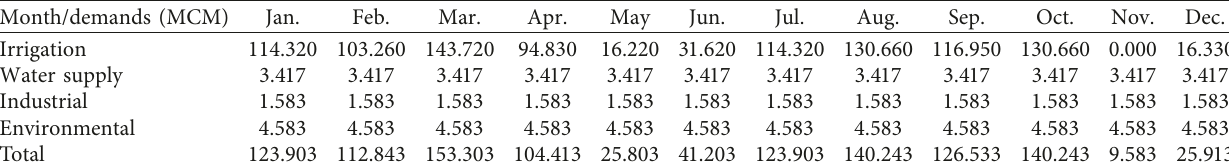
Table 1: Downstream water demands from Ubolratana